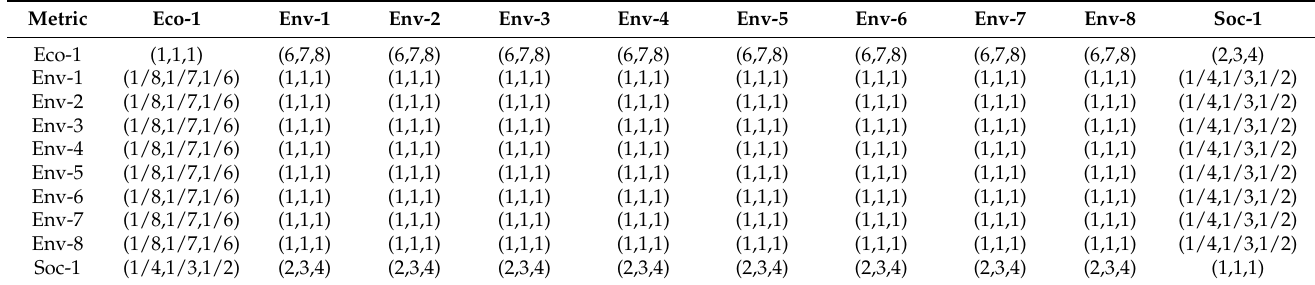
Table 9. Pairwise comparison fuzzy matrix converted to TFN reciprocal scale.